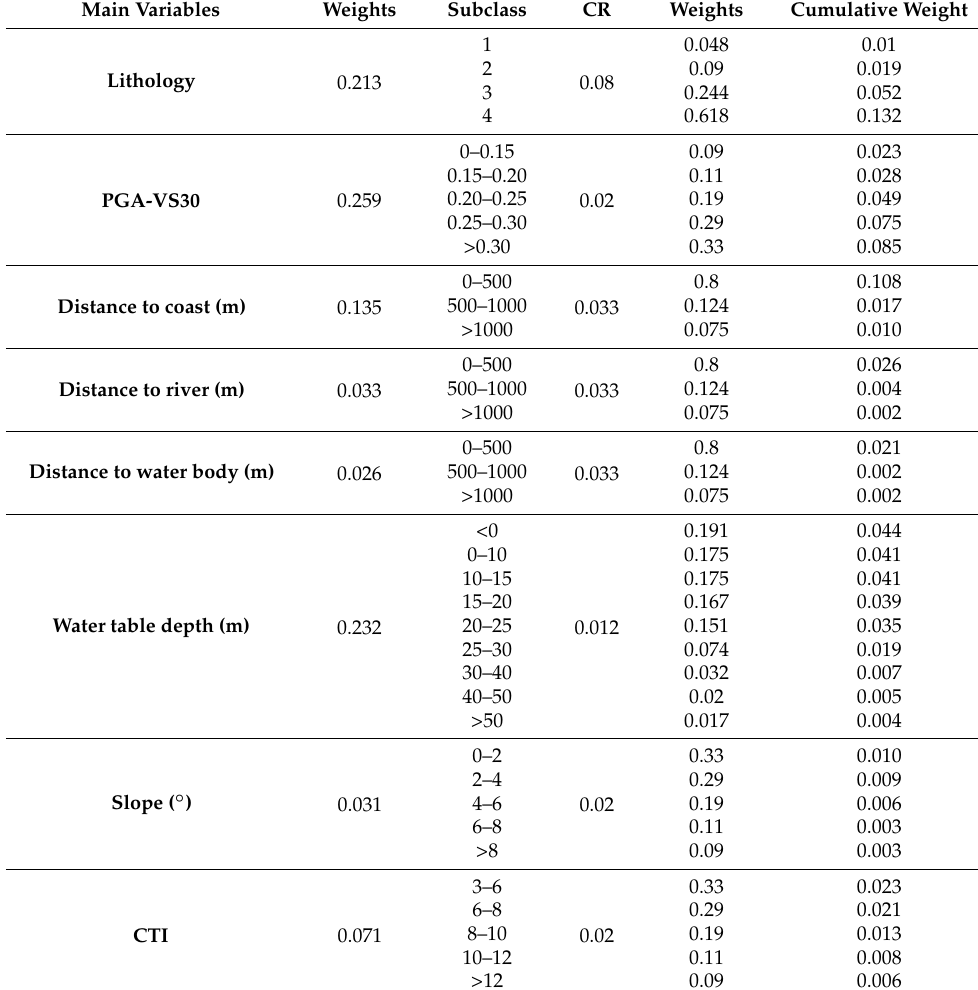
Table 3. Normalized weights obtained for the factors’ classes. The consistency ratio is also reported for each